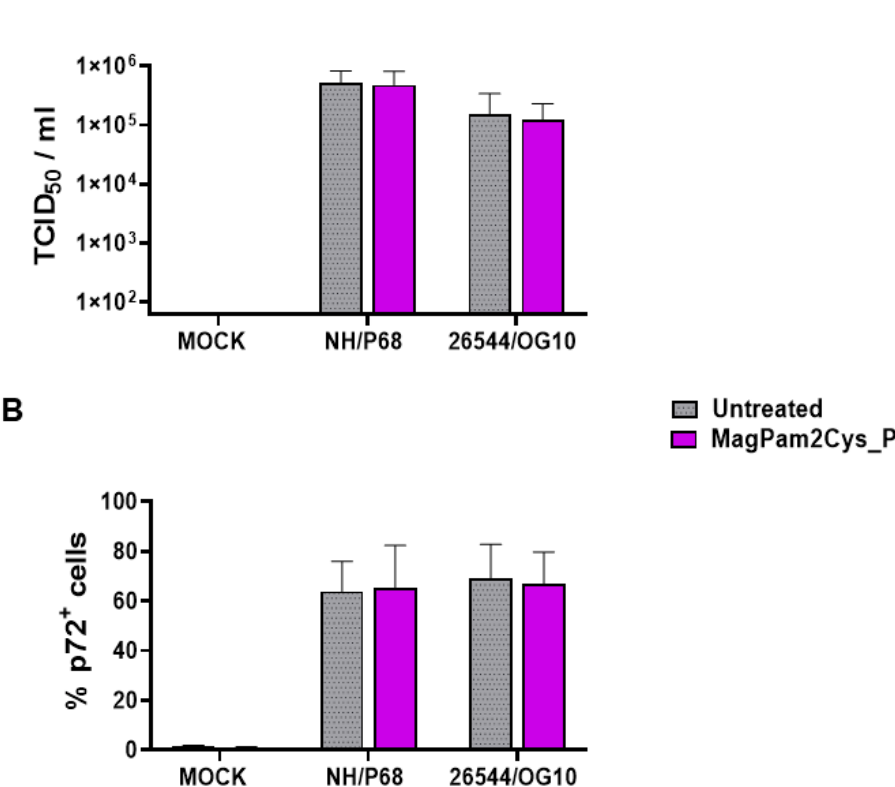
Figure 1. Impact of MagPam2Cys_P48 on porcine moM Ф susceptibility to ASFV infection. Porcine moM Φ were left untreated or stimulated with MagPam2Cys_P48 (100 ng/mL). Twenty-four hours later, cells were infected with either attenuated NH/P68 or virulent 26544/OG10, using a MOI of 1. Mock ‐ infected samples were used as controls. At 21 hpi, culture supernatants were collected, and the levels of infectious viral progeny were determined by titration (TCID 50 /mL) ( A ). In parallel, flow cytometry was conducted to determine intracellular levels of ASFV late protein p72 ( B ). The mean data + SD from five independent experiments utilizing diverse blood donor pigs are presented. For each isolate (NH/P68 or 26544/OG10), values of treated macrophages were compared to the corresponding un ‐ treated control (moM Φ ), using a Mann–Whitney test or an unpaired t ‐ test. With the aim of further characterizing the effect of MagPam2Cys_P48 on porcine moM Ф responses to ASFV, modulation of the expression of five surface markers and the release of 11 cytokines were analyzed. Macrophage subsets were infected with attenuated NH/P68 or virulent 26544/OG10 using an MOI of 1, alongside mock ‐ infected controls. At 21 hpi, surface expression of MHC class I, MHC class II DR, CD14, CD16, and CD163, and intracellular levels of late viral protein p72 were monitored using flow cytometry, using procedures previously described [21,23]. Using this experimental setup, we observed al ‐ most 60% of macrophages expressing ASFV late protein p72 (Figure 1), in accordance with our previous studies [21,23]. Thus, we were able to investigate either the direct effect of ASFV on infected cells (p72 + ) or its impact on bystander uninfected cells(p72 ‐ ) [21,23]. MHC class I and II DR expression was monitored since this can impact antigen presenta ‐ tion. Modulation of CD14 and CD16 expression can impair macrophage anti ‐ microbial/vi ‐ ral activity and previous studies reported that this virus downregulated expression of both markers [17,23]. In addition, ASFV infection can lead to reduced expression of CD163, a scavenger receptor whose expression is regulated by pro ‐ and anti ‐ inflammatory molecules [17,23]. Here we investigated whether MagPam2Cys_P48 alters ASFV modula ‐ tion of these surface markers. For each marker, both the percentages of positive cells (Fig ‐ ure 2) and the mean fluorescence intensity (MFI) of positive cells were evaluated (Figure